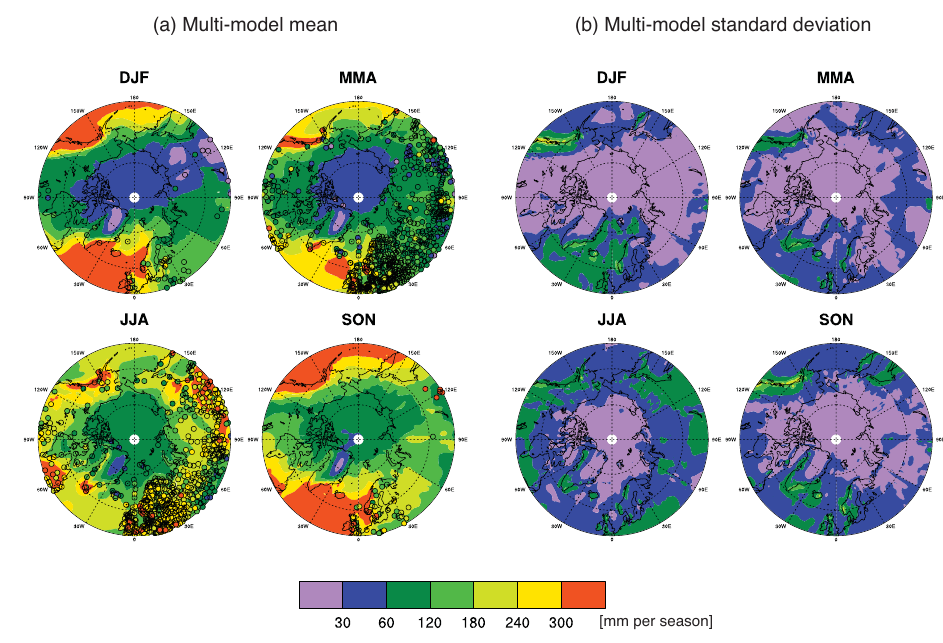
Fig. 10. Comparison of multi-model (a) mean and (b) standard deviation of seasonally accumulated precipitation rates in 2000 to gauge-based precipitation measurements (Yang et al., 2005) from 1995 to